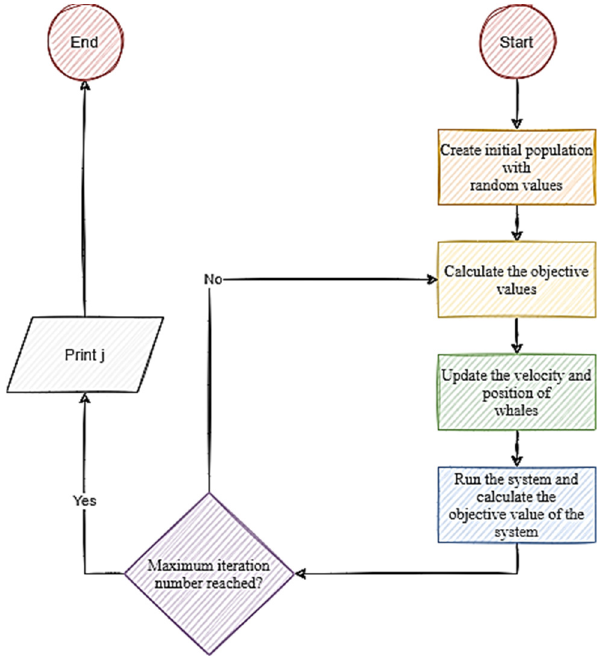
Figure 4. Flow chart of WOA.